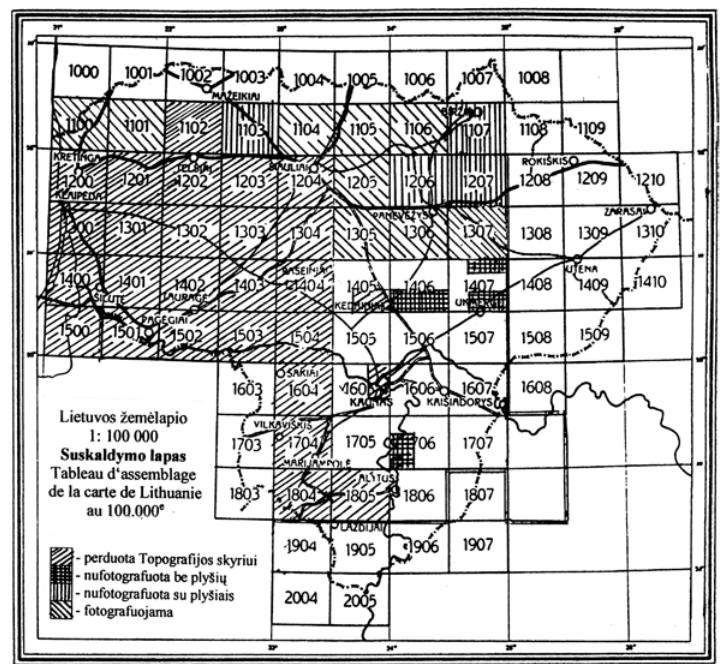
Fig. 1 . Cartogram of works of aerogeodesy